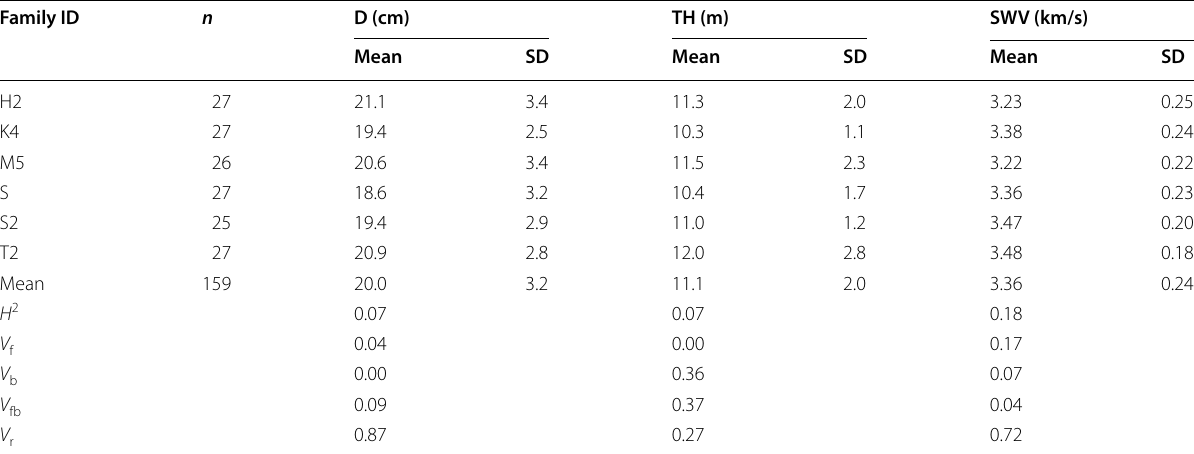
Table 1 Family mean values and ratio of variance components for traits measured in standing trees Family ID